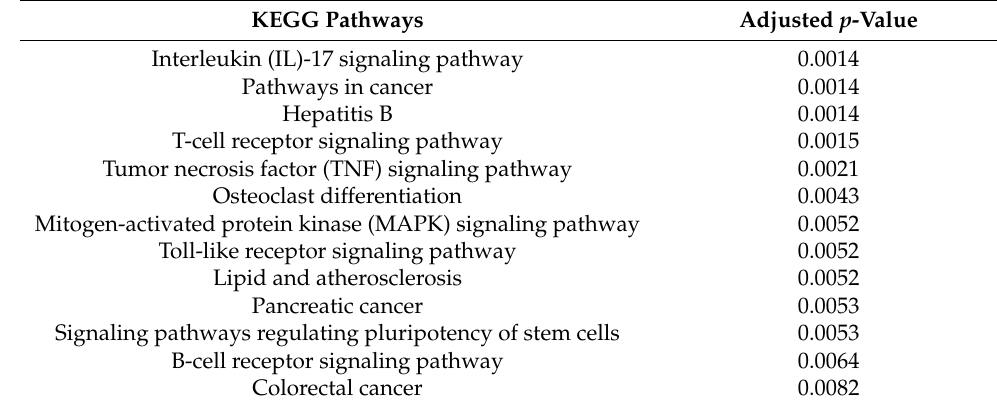
Table 4. Kyoto Encyclopedia of Genes and Genomes (KEGG) pathways enriched by the target genes of miRNA top-ranked by the random forest regression’s feature-importance score (adjusted p -value <